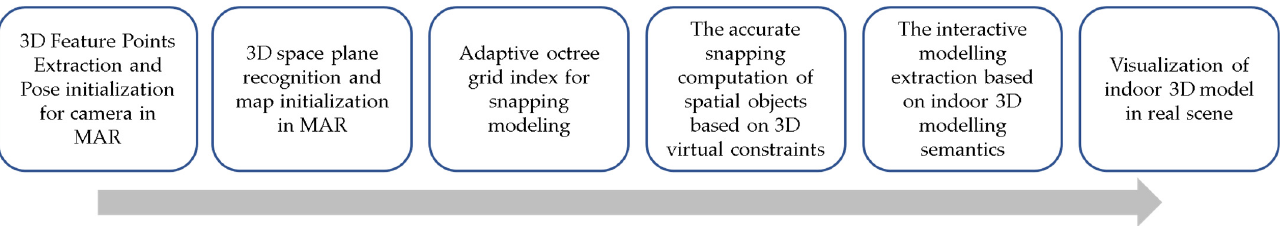
Figure 2. The pipeline of accurate 3D modeling in MAR.